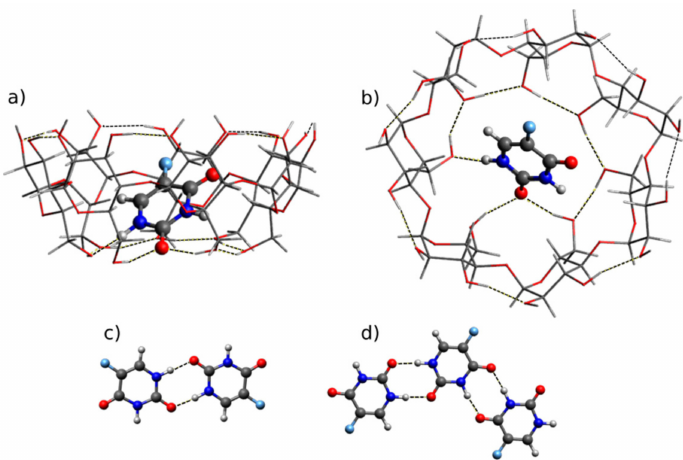
Figure 3. B3LYP-D3 / 6-31 + G(d,p) calculated structures of ( a , b ) the most stable complex of 5-FU with = − 195 kJ / mol, [37]) and ( c ) the 5-FU dimer and ( d ) β -CD ( E int